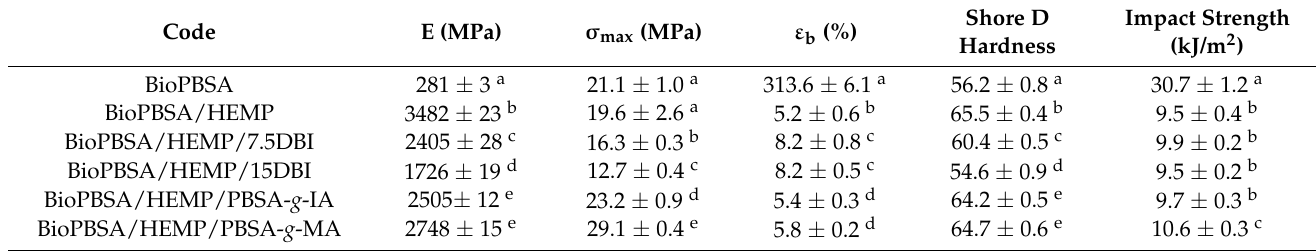
Table 2. Summary of mechanical properties of the BioPBSA/HEMP composites in terms of tensile modulus (E), maximum tensile strength ( σ max ), elongation at break ( ε b ), Shore D hardness and impact